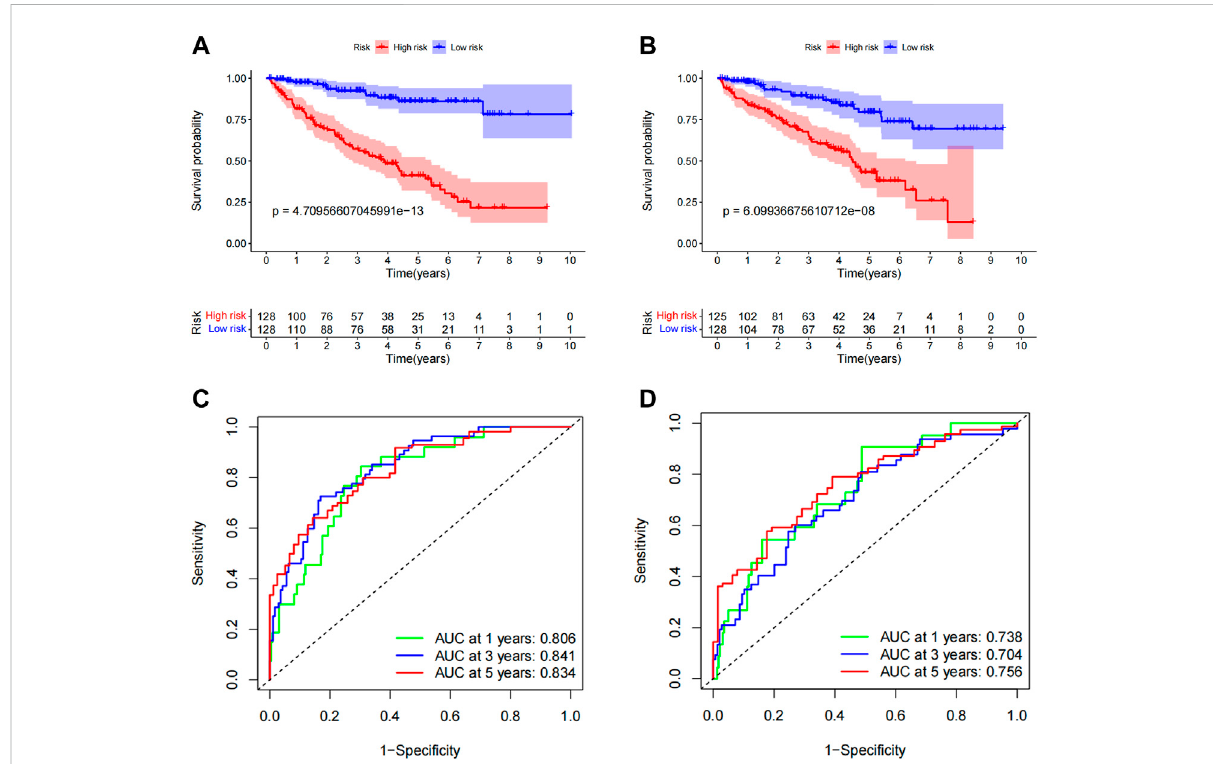
FIGURE 8 Internal validation of OS prediction signatures based on the TCGA dataset. (A) Kaplan-Meier survival curves for the training group. (B) Kaplan- Meier survival curves for the testing group. (C) ROC curves and AUCs for 1-, 3-, and 5-year survival rates for the training group. (D) ROC curves and AUCs for 1-, 3-, and 5-year survival rates for patients in the testing group. ROC, receiver operating characteristic; AUC, area under the curve; OS, overall survival; TCGA, Cancer Genome Atlas.